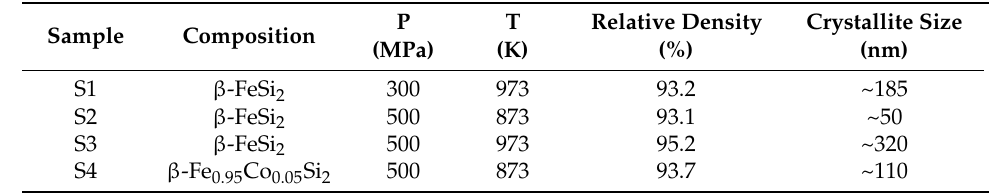
Table 1. Influence of the sintering conditions (pressure and temperature) on the relative density and the crystallite size of β -FeSi 2 and β -Fe 0.95 Co 0.05 Si 2 for a dwell time of 5 min. P Sample Composition